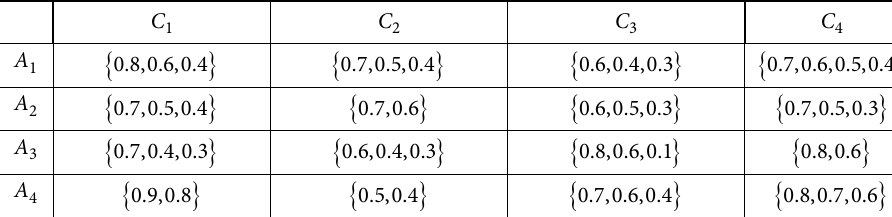
Table 2. Hesitant fuzzy decision matrix of expert e 2